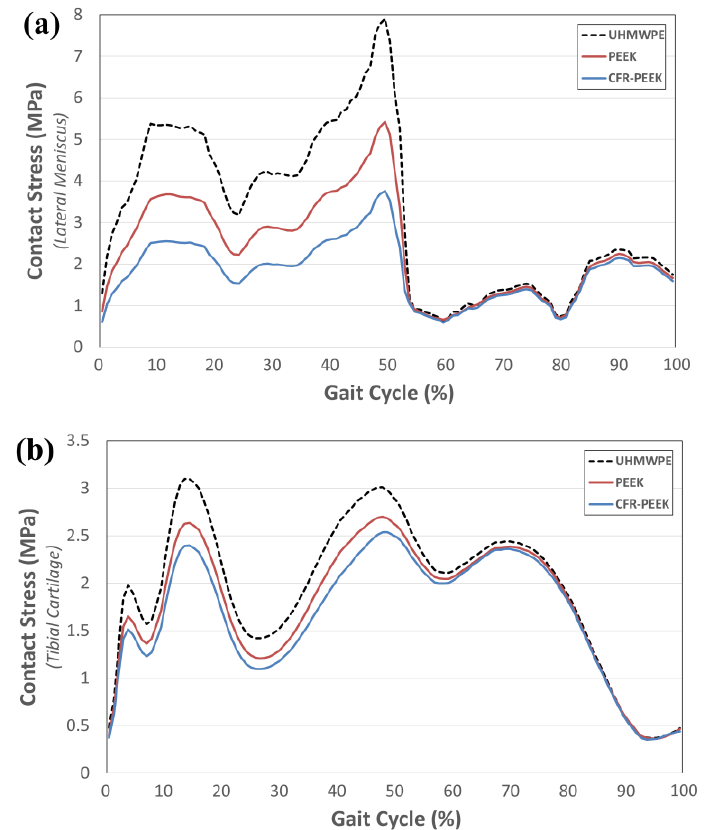
Figure 5. Comparison of contact stress on ( a ) the lateral meniscus and ( b ) tibial cartilage in regard to different tibial bearing materials during the gait cycle.